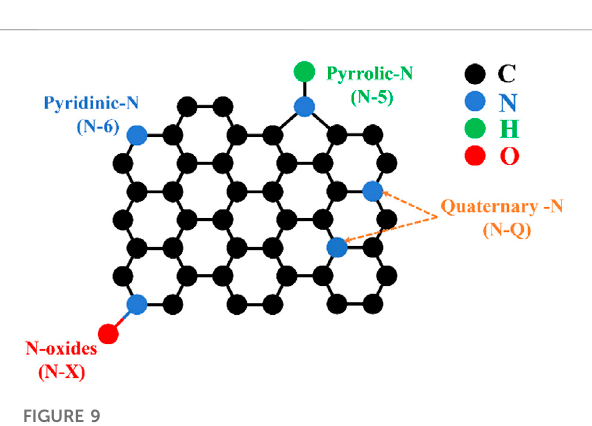
Schematic illustration of N functionalities (Zhang et al.,